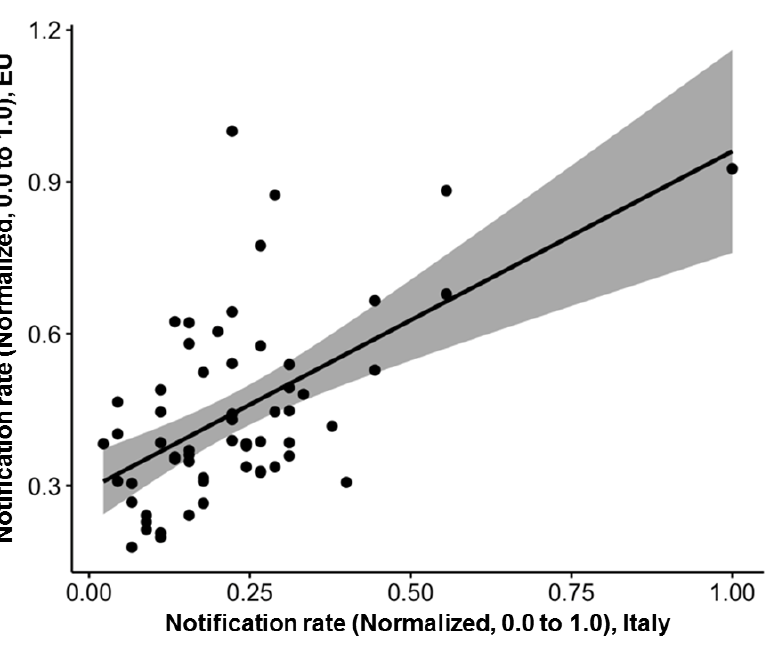
Figure 2. Correlation between notification rates in Italy and in the rest of European Union, reported as monthly rates normalized by maximum values. Notification rates per 100,000 persons and foreign-born residents per 100 people, calculated at regional level (Italy, 2010–2020) (R = 0.48, p < 0.001). Focusing on the suspected source of infection, the majority of cases had a previous sojourn in Asian countries, either southern and eastern Asia (26.9%) or Southeast Asia (25.1%), followed by Caribe (19.7%; for a total of 26.2% when considering all the Latin American countries as a whole), Africa and Middle East (6.7%).